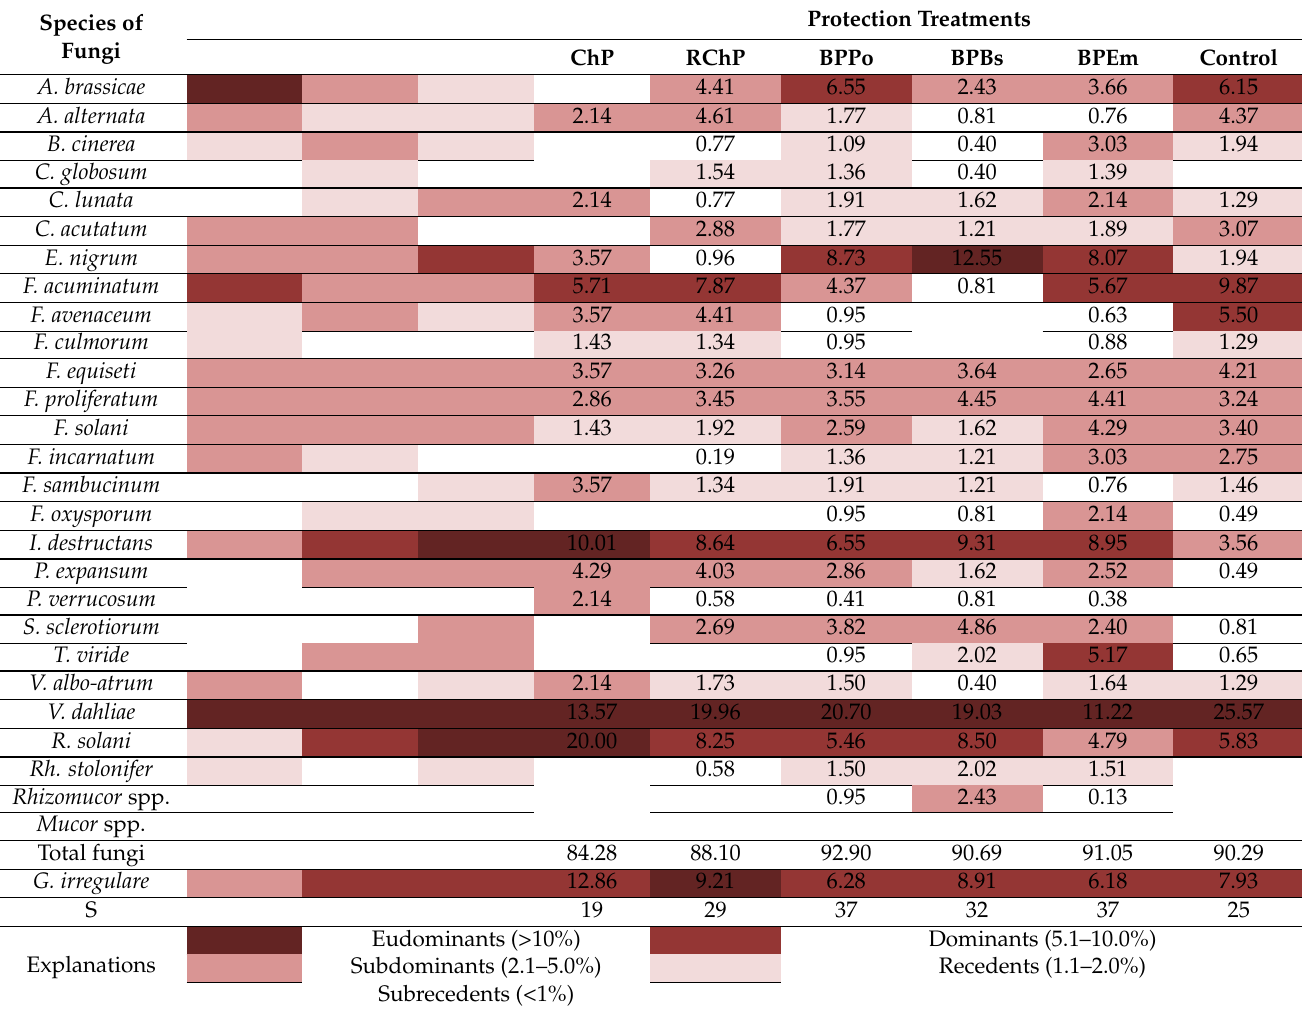
Table 5. Frequency of species in microbial communities isolated from horseradish